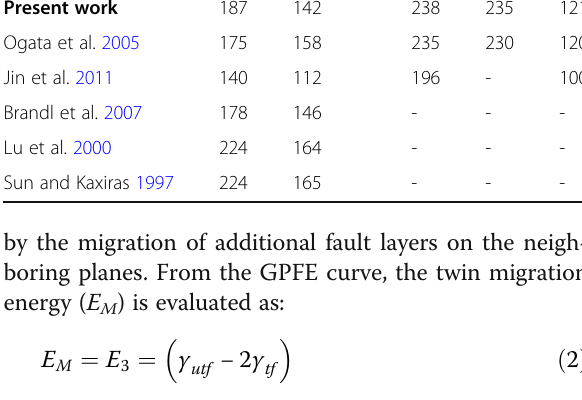
Table 1 Various stacking fault energies calculated for the Al crystal. The present results are also compared with those published in the earlier studies. All values are given in mJ m − 2